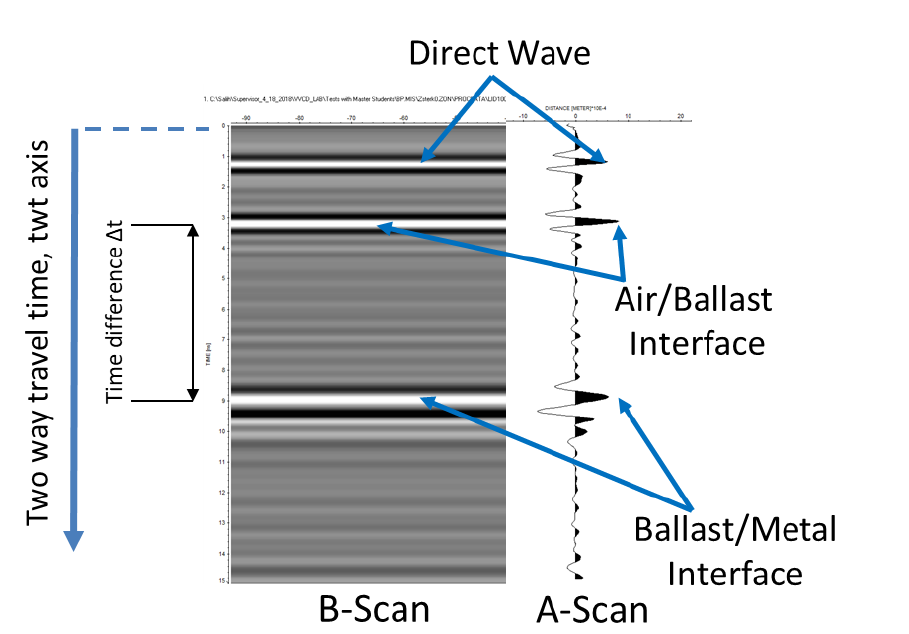
Figure 1. Schematic presentation of air/ballast interface and ballast/bottom interface (from 2 GHz air-coupled antenna) (adapted from [25]).